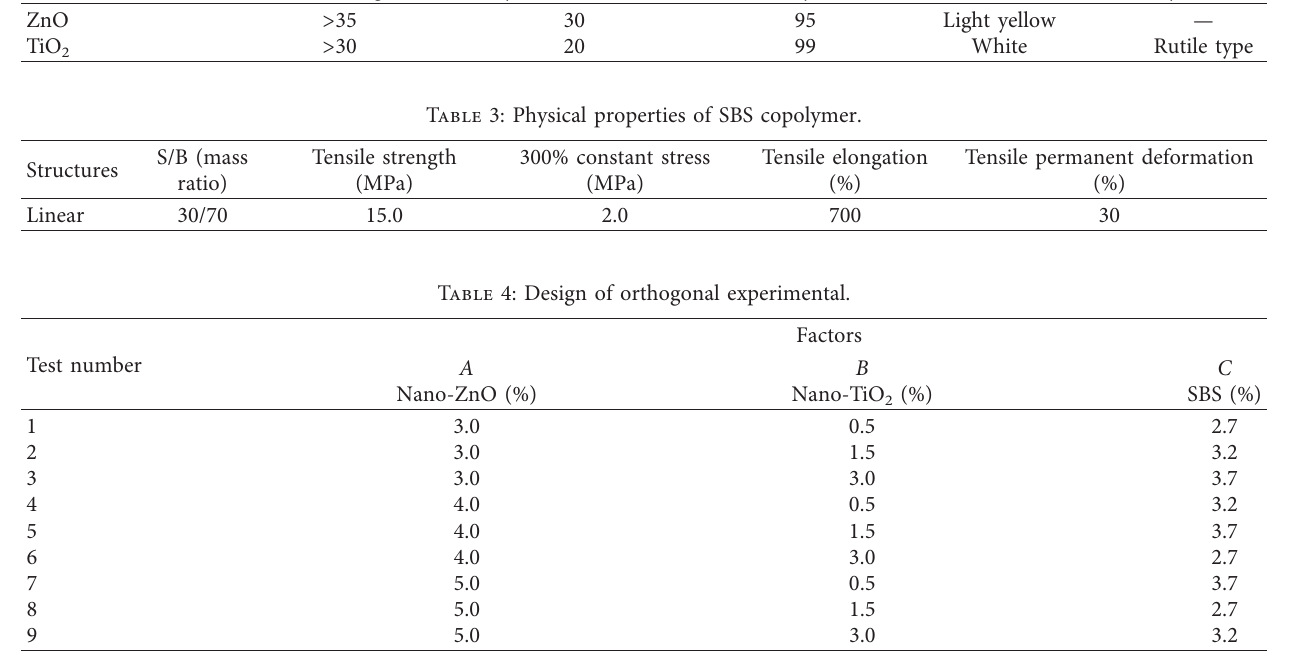
Table 2: Properties of nano-ZnO and nano-TiO